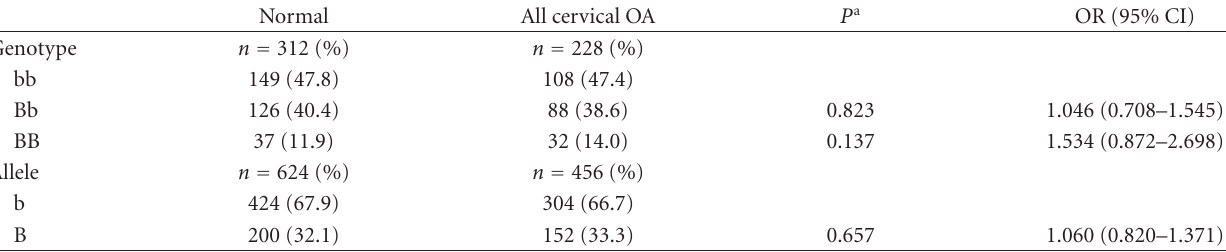
Table 5: Genotype and allele frequencies and odds ratios of MATN3 SNP6 (rs8176070) in control, cervical OA cases. Normal All cervical OA P a OR (95% CI)